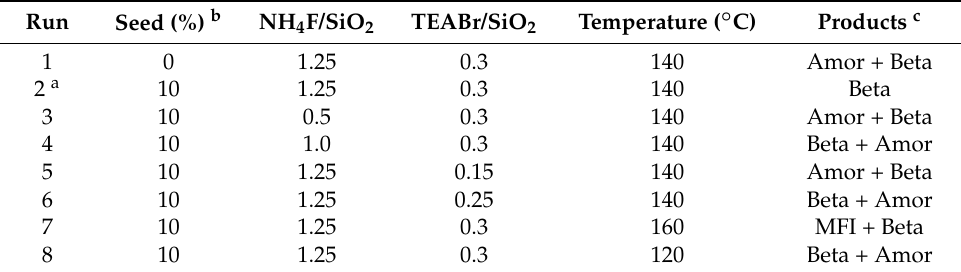
Table 1. Synthesis of S-Beta sample under various conditions.